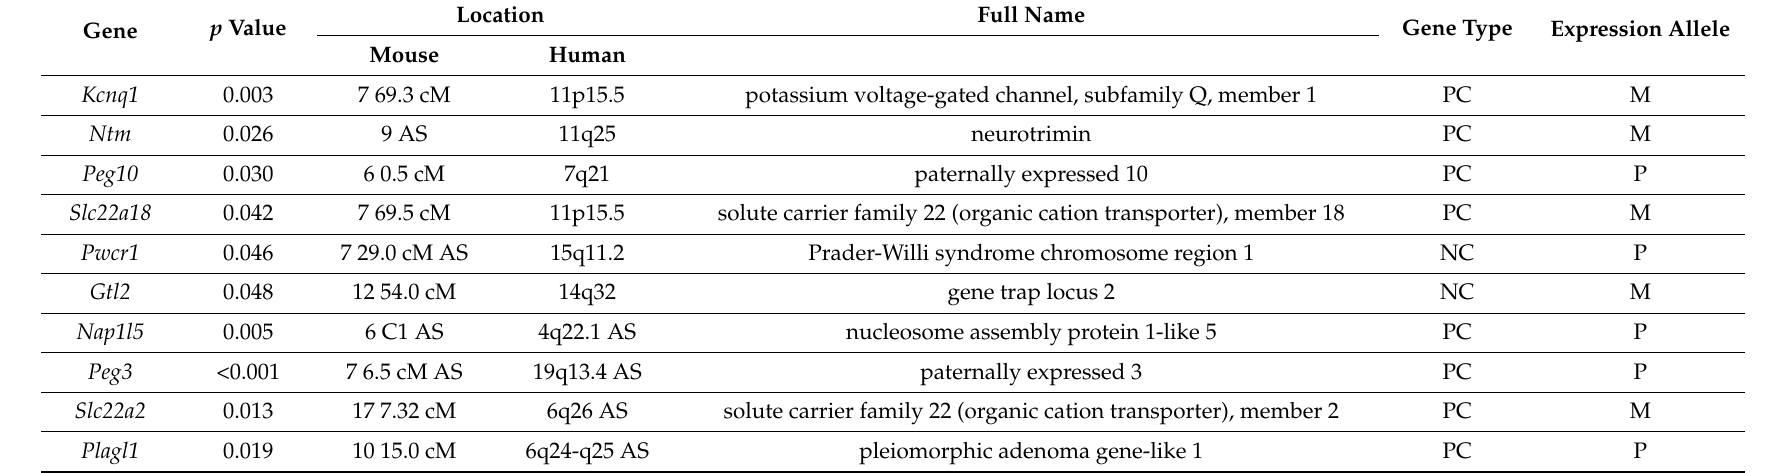
Table 2. Information of differentially expressed imprinted